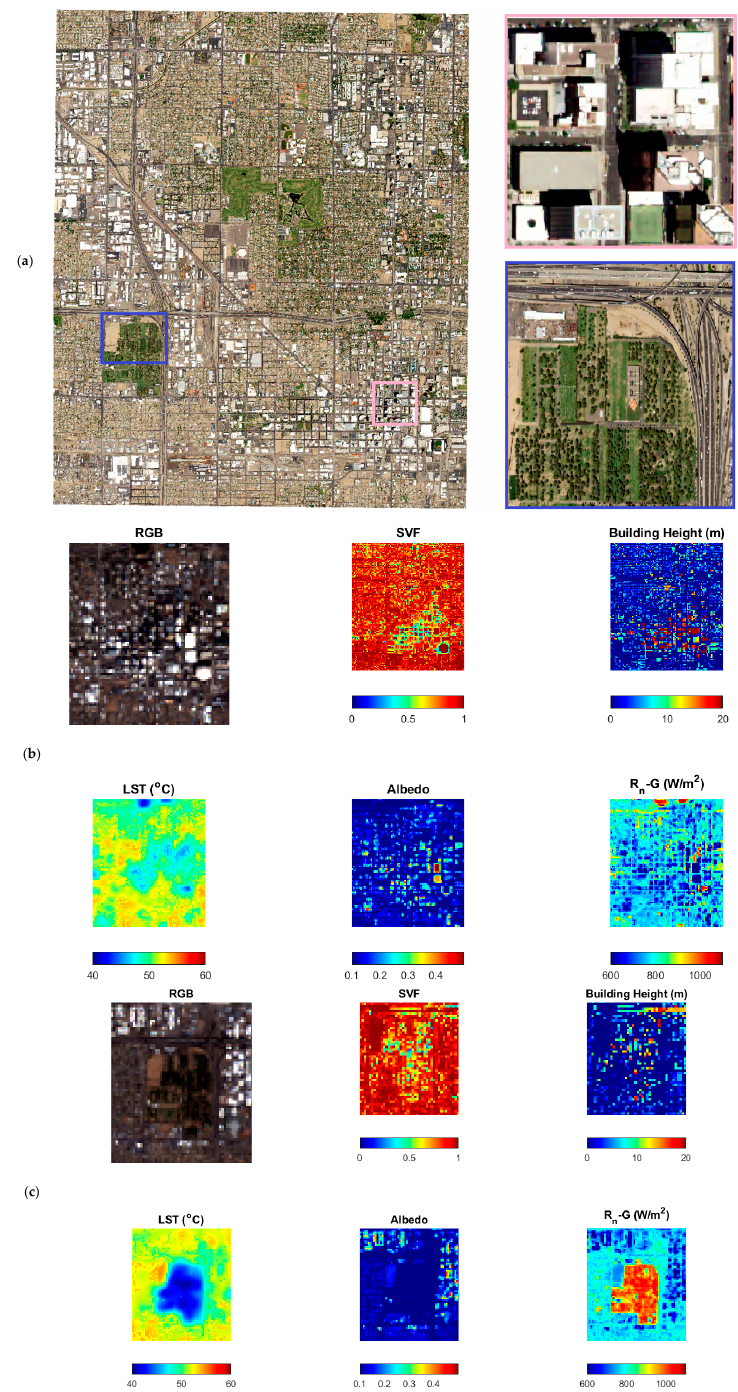
Figure 3. ( a ) Aerial imagery of downtown Phoenix acquired through NAIP imagery; site delineated with blue box shows a lush tree turf landscape, and pink box shows downtown with high-rise build- ings; ( b ) downtown site shown in ( a ) with a pink box with red, green, and blue image (RGB), sky view factor (SVF), heights of the buildings, LST, surface albedo, and available energy (Rn-G) values; ( c ) lush vegetated surface zoomed-in blue box with RGB image, SVF, heights of the buildings, LST, surface albedo, and available energy (Rn-G) values.